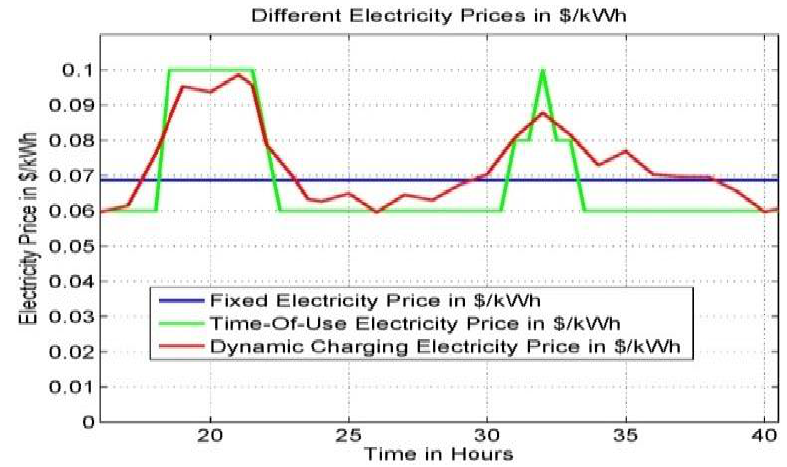
Figure 4. Electricity cost (electricity rate) profile for, fixed price, time-of-use price, and dynamic price.